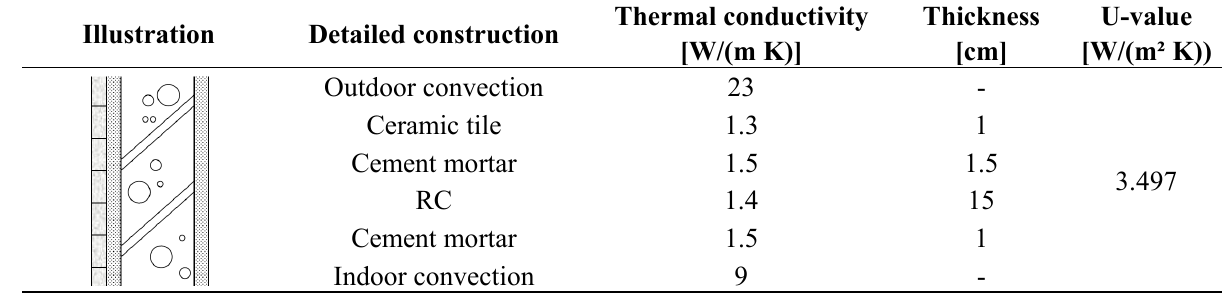
Table 2. Details of the RC exterior wall and the thermal properties of each layer of material. Illustration